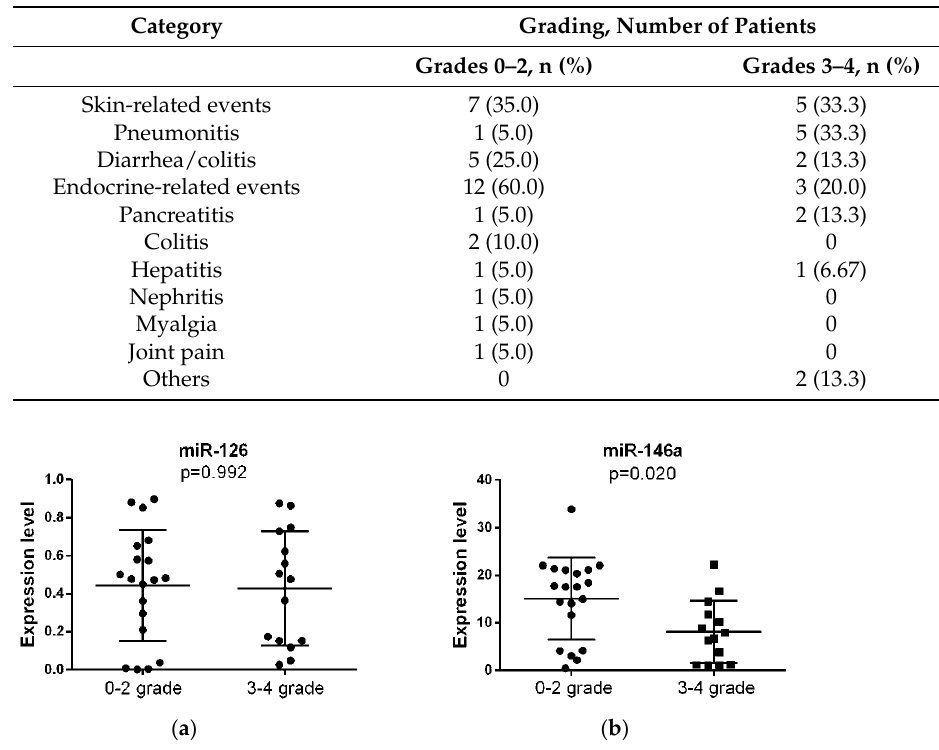
Figure 2. Expression levels of exosomal miRNAs in clear cell renal cell carcinoma patients with different grades of immune-related adverse events after second-line nivolumab therapy: ( a ) miRNA-126; ( b ) miRNA-146a. Significance level p -value was calculated using Mann–Whitney U test. 0–2 grade, 3–4 grade—grades of irAEs.